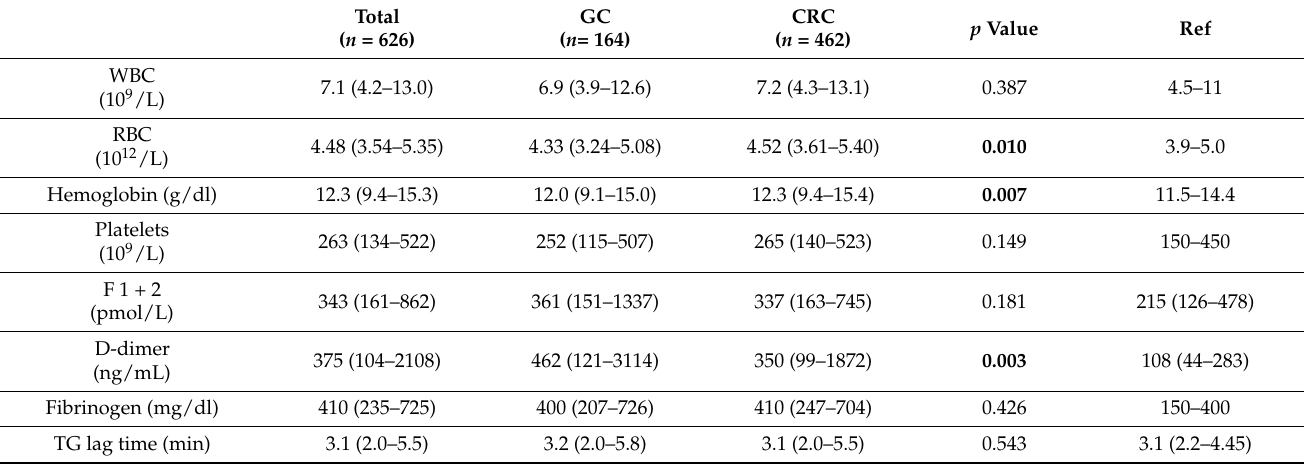
Table 2. Hematological parameters and plasma levels of coagulation biomarkers according to site of